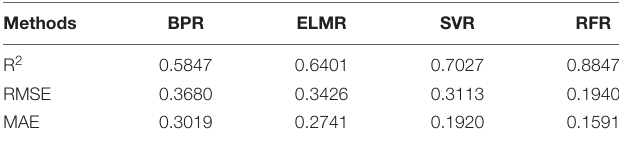
TABLE 6 | The R 2 , RMSE and MAE of the training